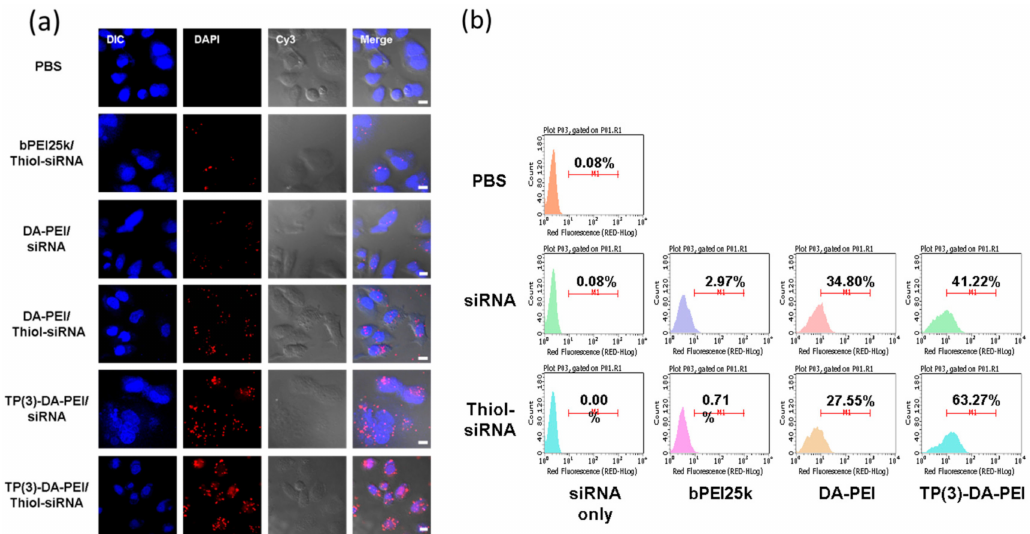
Figure 6. Intracellular uptake of TP(3)-DA-PEI/thiol-siRNA monitored by confocal microscope ( a ) and flow cytometry ( b ). A549 cells were treated with Cy3 labeled siRNA (or thiol-siRNA) complexed with DA-PEI or TP(3)-DA-PEI at polymer/siRNA weight ratio of 3, * p < 0.05. Polyplexes from bPEI25k and siRNA (or thiol-siRNA) (weight ratio = 1) were used as control. Nuclei were stained with DAPI (blue). Scale bars: 10 µ m. M1 represents arbitrarily gated